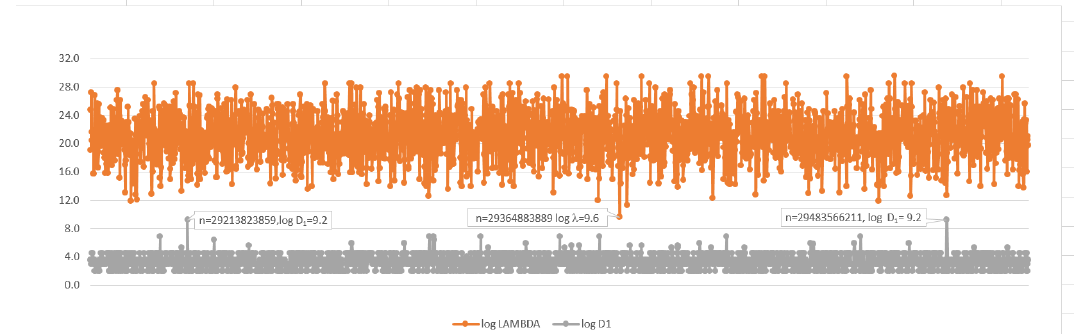
Figure 7. p 1 = 11, m = 6, p m ≤ 199.